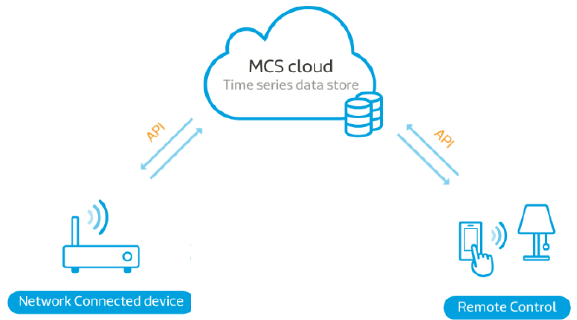
Figure 1. System Architecture diagram of the MediaTek Cloud Sandbox (MCS). Where API is the application programming interface.